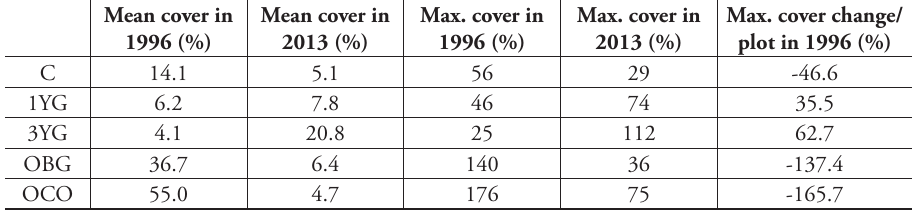
Table 3. Total vegetation cover (%) in 1996 and 2013 in the five stand developmental situations. For explanations of the stand developmental situations, see methods.